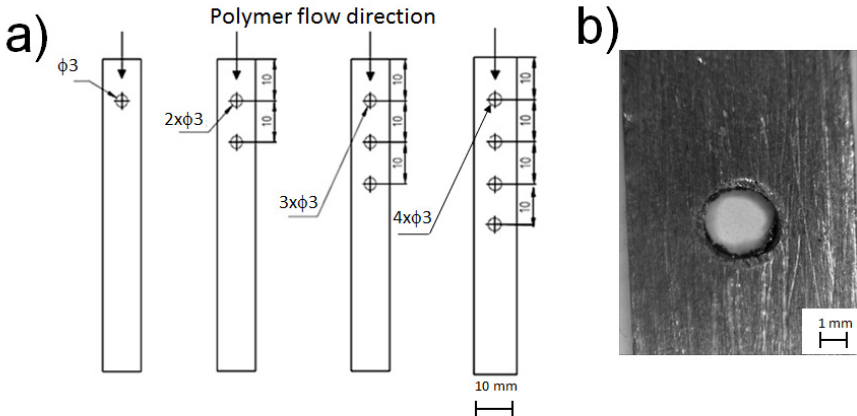
Figure 1. View of polymer-metal connection. ( a ) Hole allocation on metal plates, ( b ) example of a single hole.